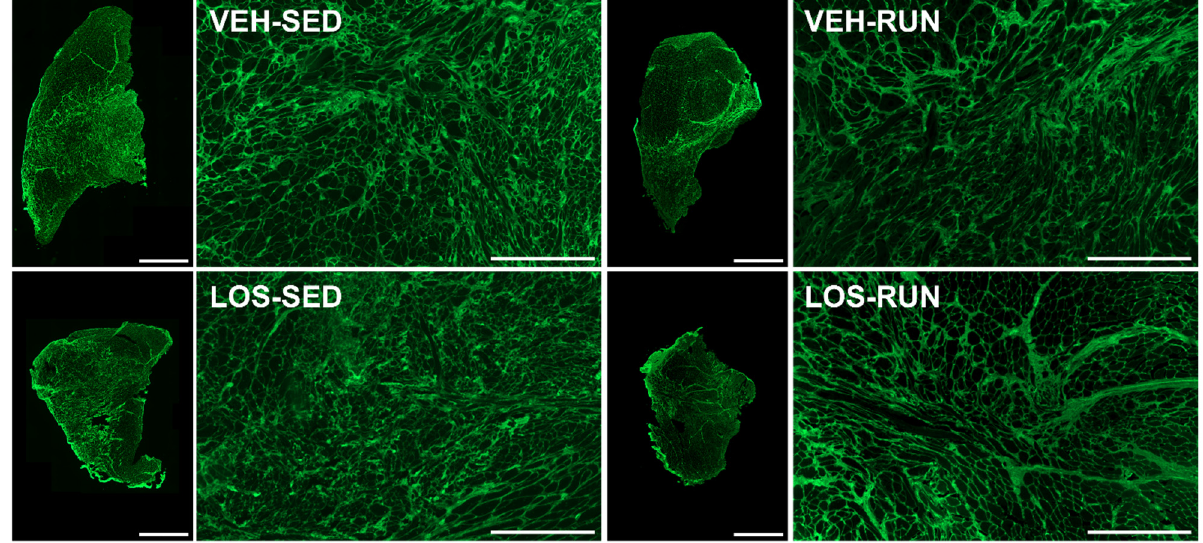
Figure 6. Qualitative evaluation of muscle fiber boundaries via WGA staining in VML-injured TA cross-sections at 56 DPI. All groups, regardless of antifibrotic treatment or rehabilitation, displayed similar fiber distributions with small fibers in the VML defect site and larger fibers in the uninjured regions. TA muscle cross-section scale bars = 2000 µm and VML defect site scale bars = 500 µm.